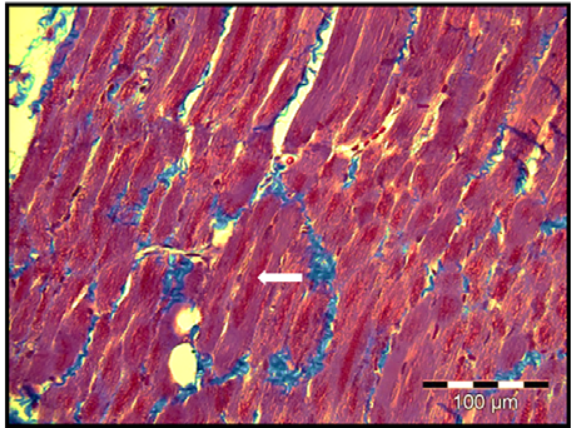
Figure 3b: Masson trichrome stain of the left m. longissimus dorsi muscle exhibiting elongated red sarcoplasmic nemaline rods bodies (arrow), with interstitial collagen staining blue. Light microscopy, magnification